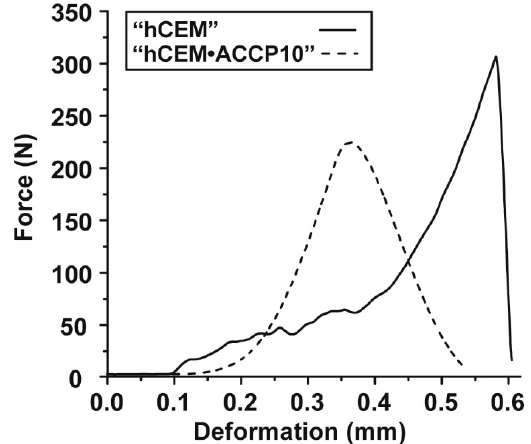
Figure 8. Force–displacement reaction of “hCEM” (solid line) in comparison to the one of the “hCEM•ACCP10” material (broken line).